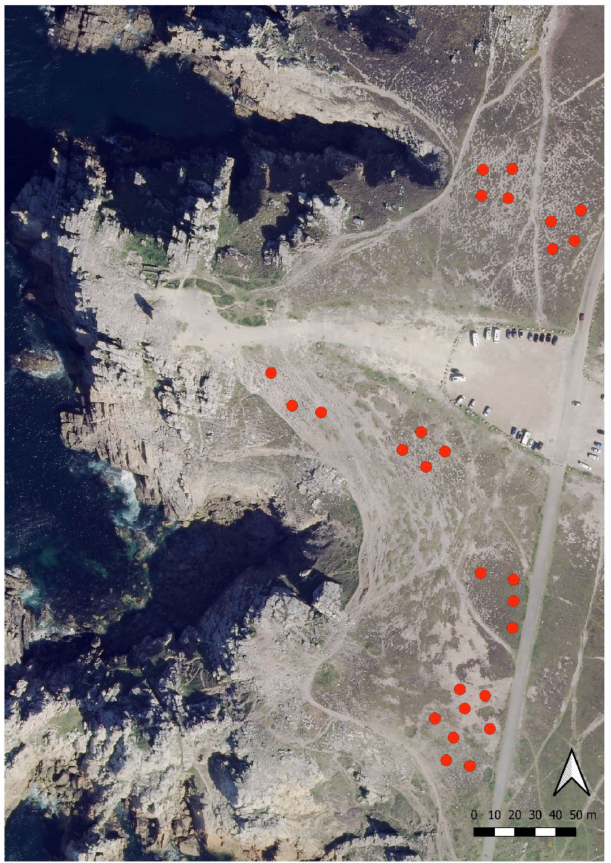
Figure 1. Pitfall traps arrangement in La Pointe de Pen-Hir (S1) as an example. Samples of pitfall and bait traps were sorted, transferred to ethanol 70 ◦ , and stored at the University of Rennes 1. Ants were identified to species level using keys of Blatrix [30] and of Seifer [31–33]. For further sites description see